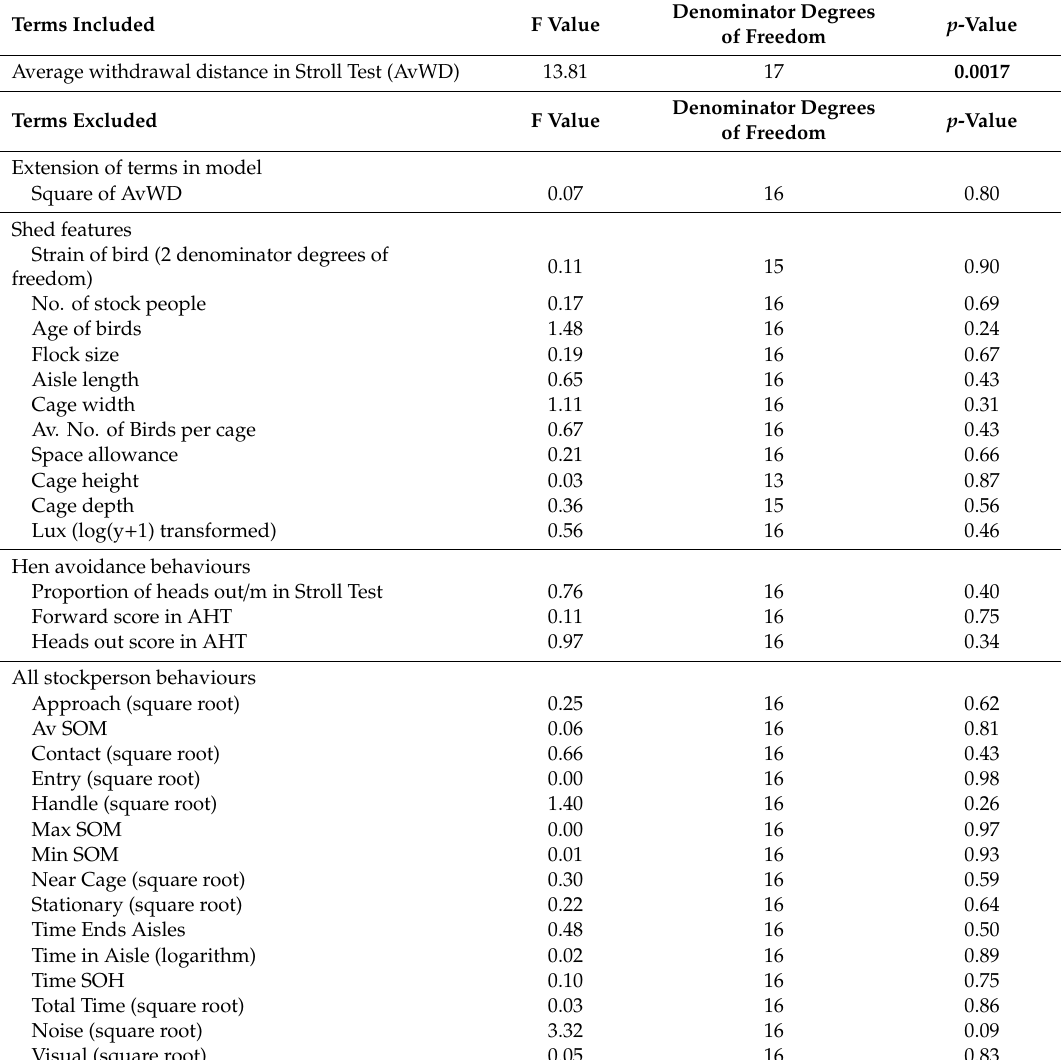
Table 5. Tests for including and excluding fixed e ff ect terms in the model relating the logarithm of albumen corticosterone concentration to physical features of the laying house, hen avoidance behaviours and all stockperson behaviours. Tests for the inclusion of terms for the main stockperson